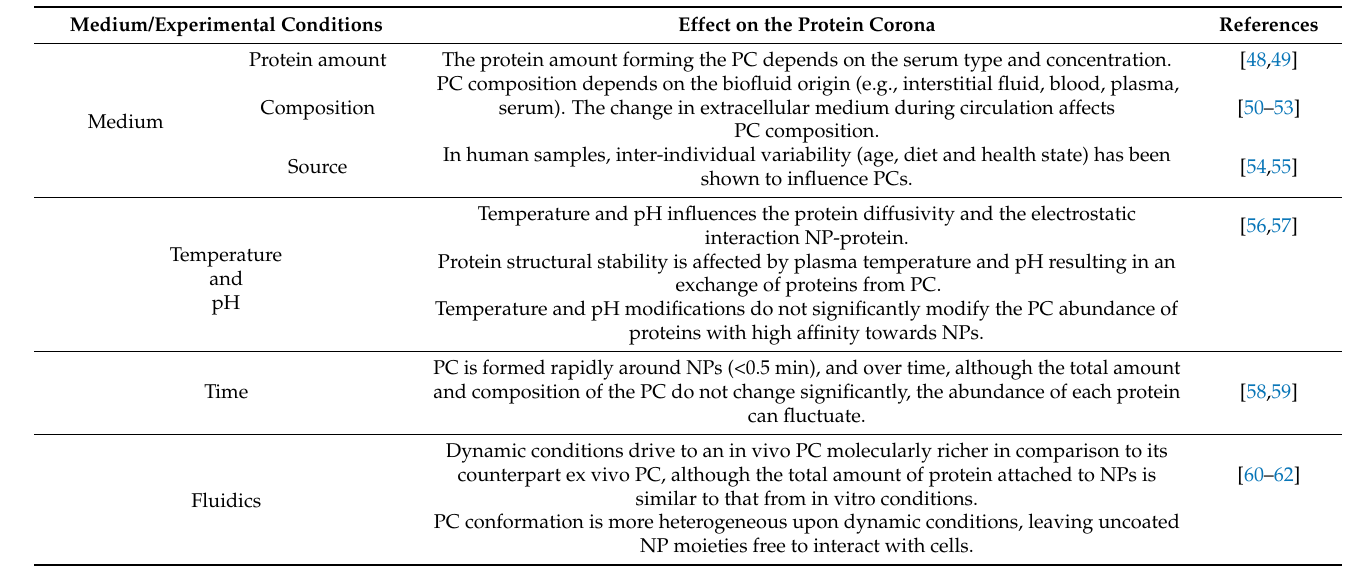
Table 2. Medium and experimental conditions influencing the generation of the Protein Corona. Adapted from